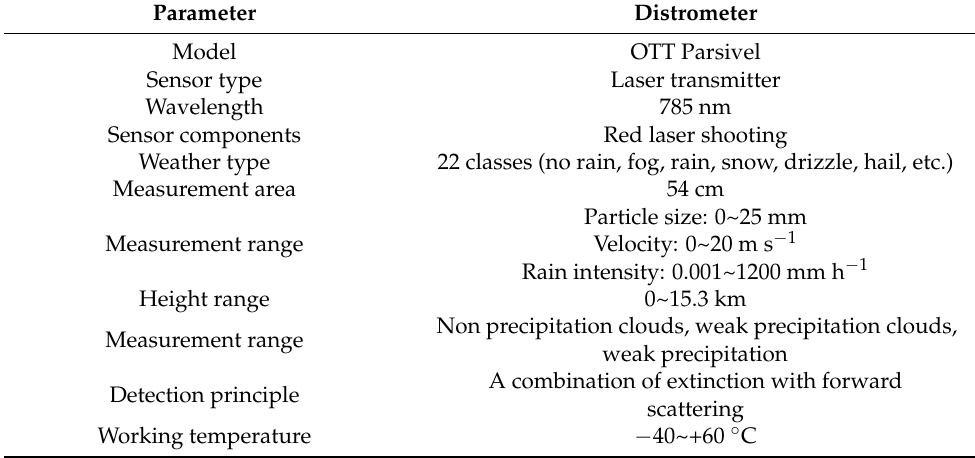
Table 2. Main specifications of